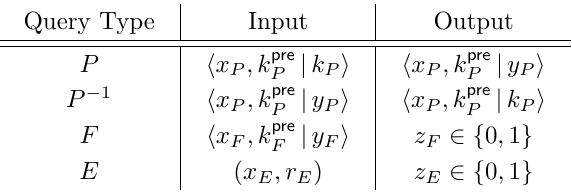
Table 1: Inputs and outputs of the four oracle query